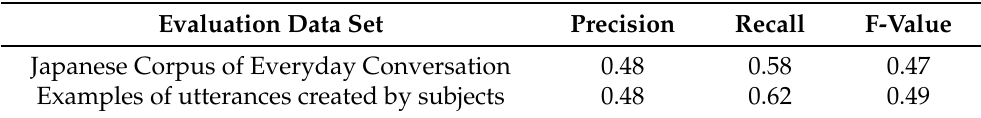
Table 4. Average of precision, recall and